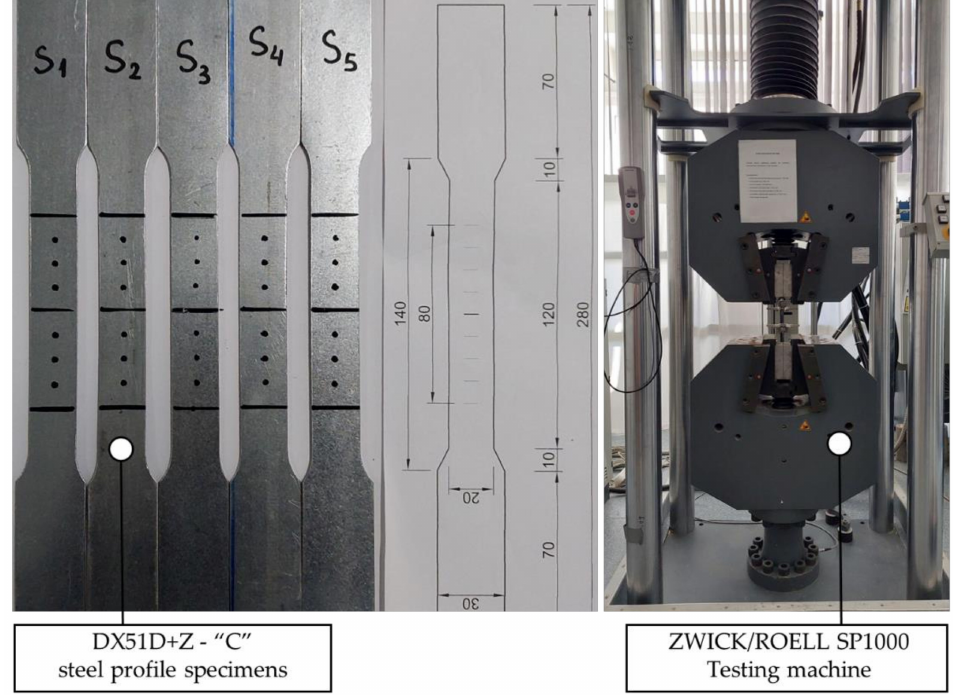
Figure 10. Tensile test specimen prepared and Zwick/Roell SP1000 machine